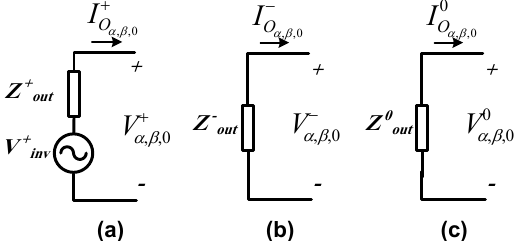
Figure 7. ( a ) positive-; ( b ) negative- and ( c ) zero-sequence models of the DG